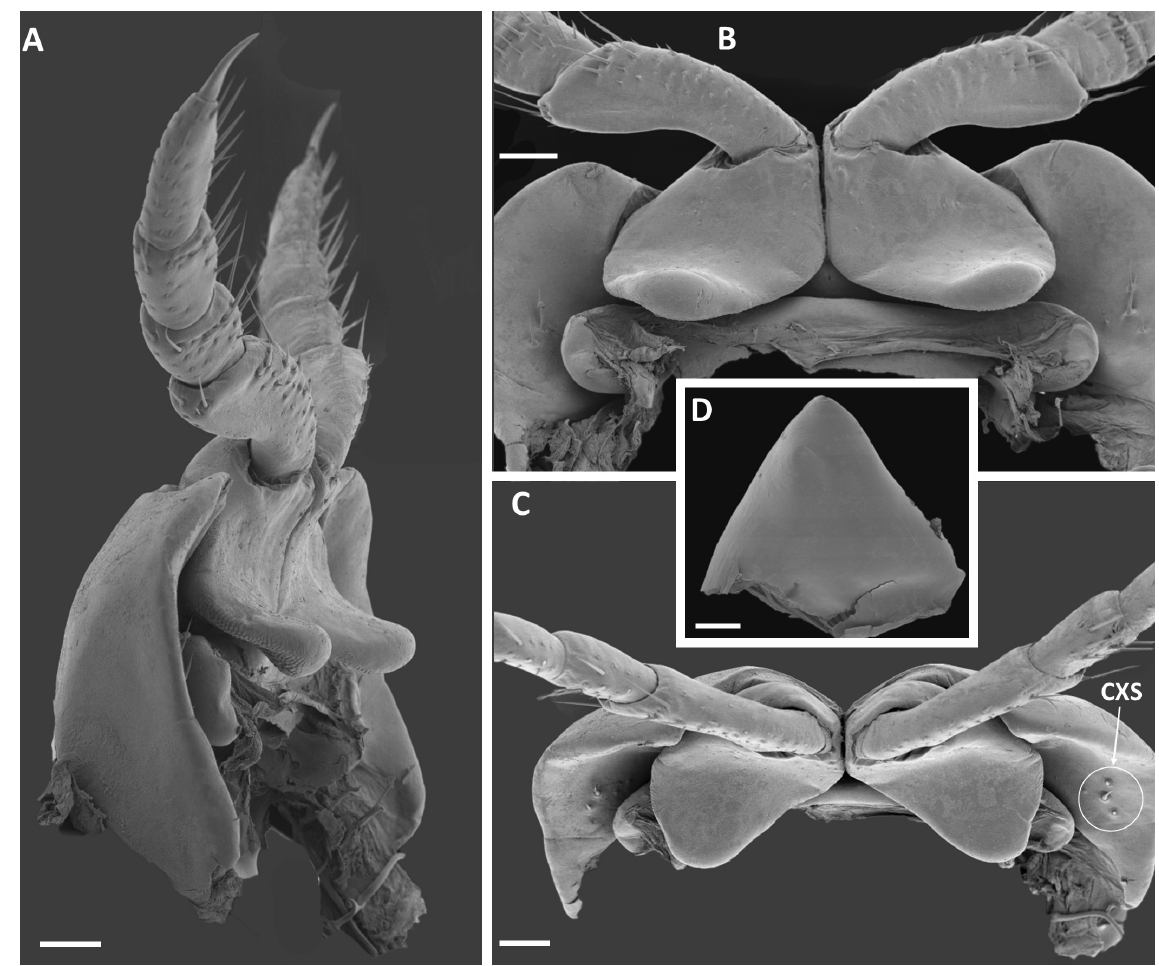
Fig. 31. Chaleponcus sergeii sp. nov., holotype, ♂ (NHMD 621728). A–C . First pair of legs. A. Sublateral view. B. Anterior view. C. Ventral view. D . Sternum 9. Abbreviation: CXS = coxosternal setae. Scale bars = 0.2